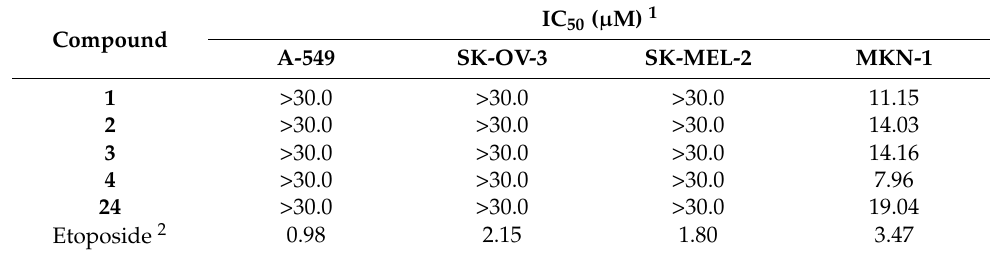
Table 5. Cytotoxicity of selected compounds against four cultured human cell